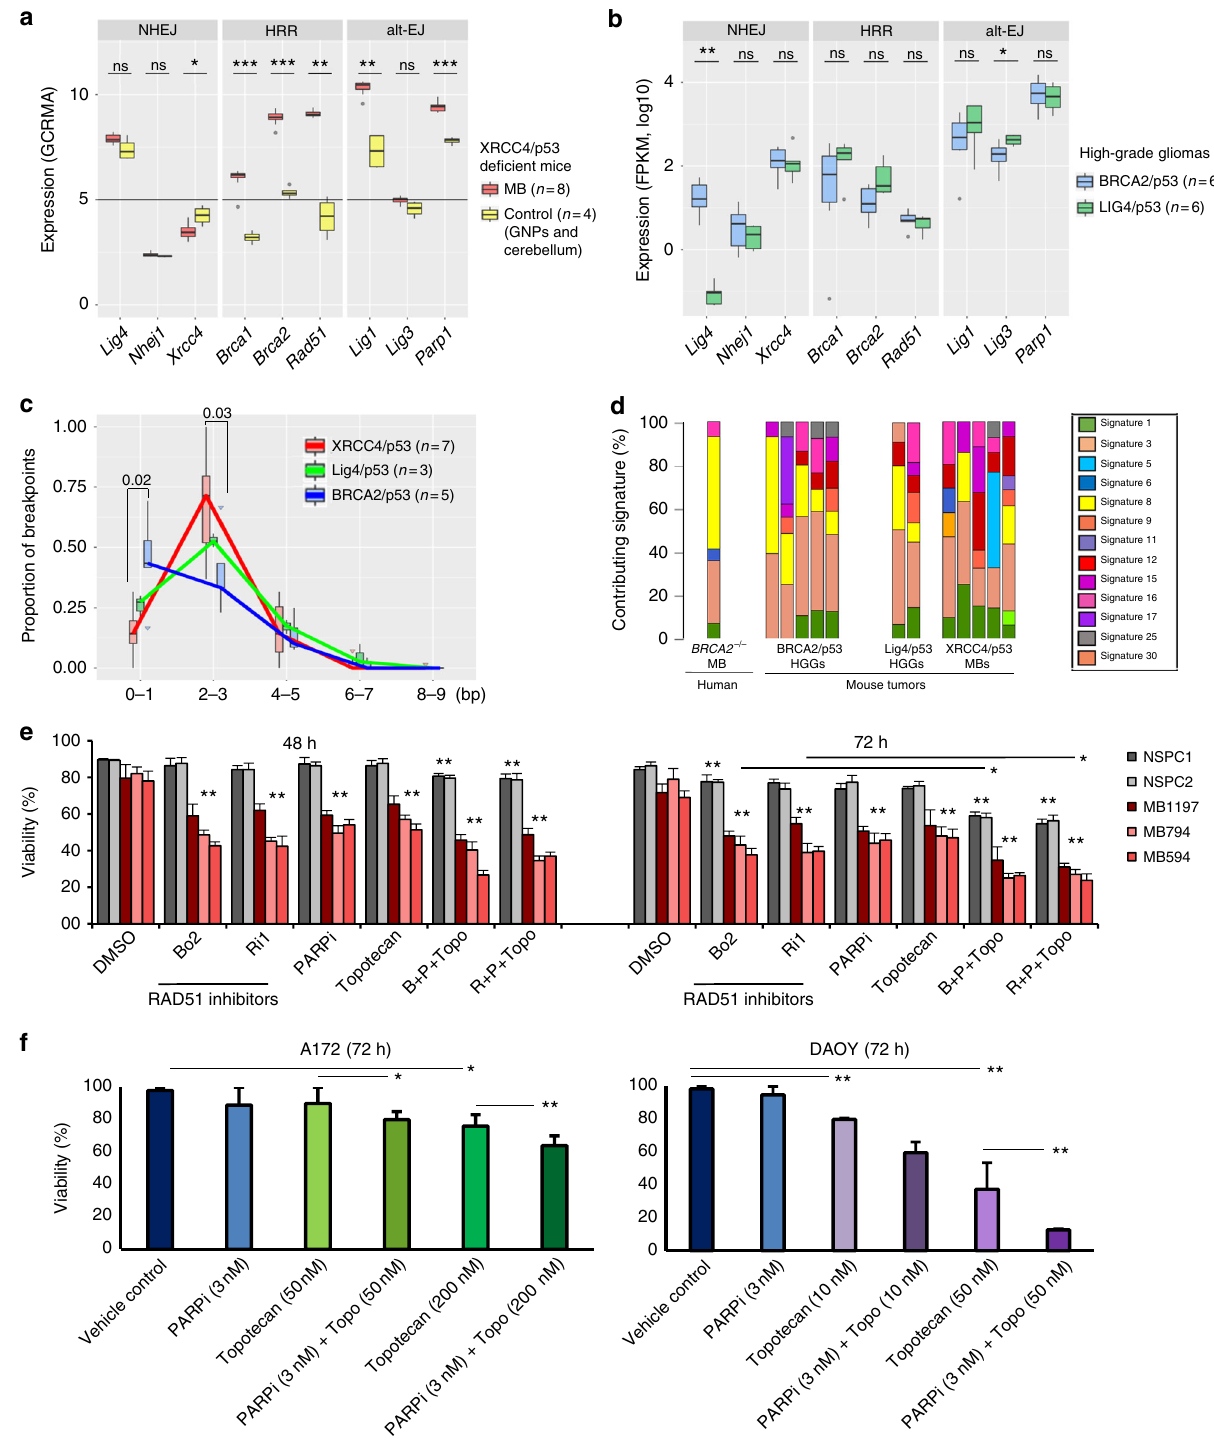
same treatments to neural progenitor cells from age-matched heterozygous animals ( Nestin-Cre p53 − / − Xrcc4 + / − ). Combina- tions of RAD51 inhibitor, PARP inhibitor and topoisomerase inhibitor signi fi cantly decreased the viability of the MB cells without affecting the viability of the normal neural progenitor cells for short-term treatment (up to 48 h, Fig. 4e and Supplementary Figure 7). For longer treatments, the viability of the neural progenitor cells was reduced at the tested concentra- tion for the combination treatment, but the fraction of viable cells